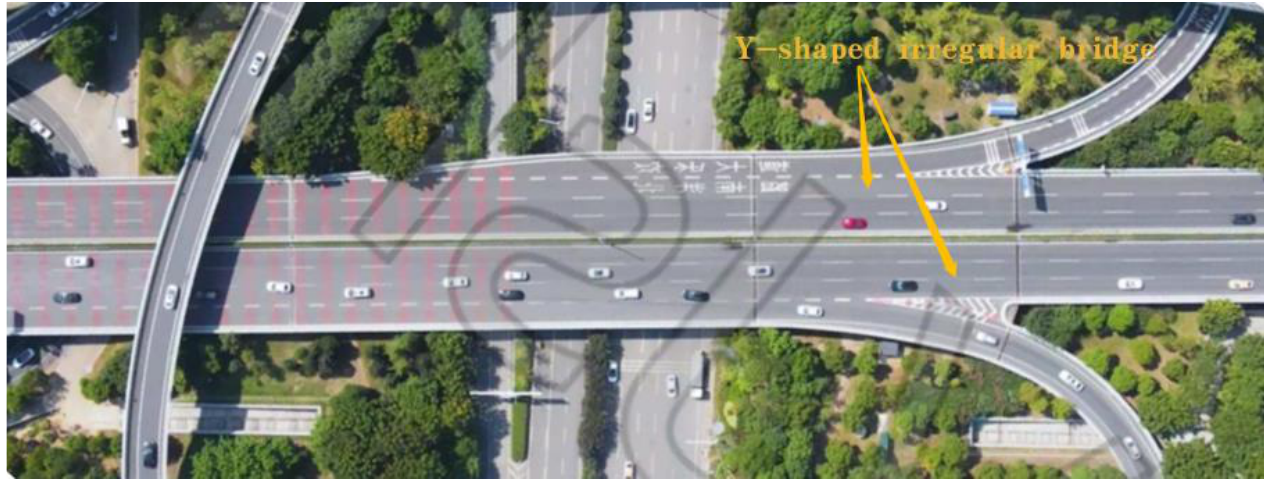
Figure 1. Example of the Y-shaped irregular bridge.